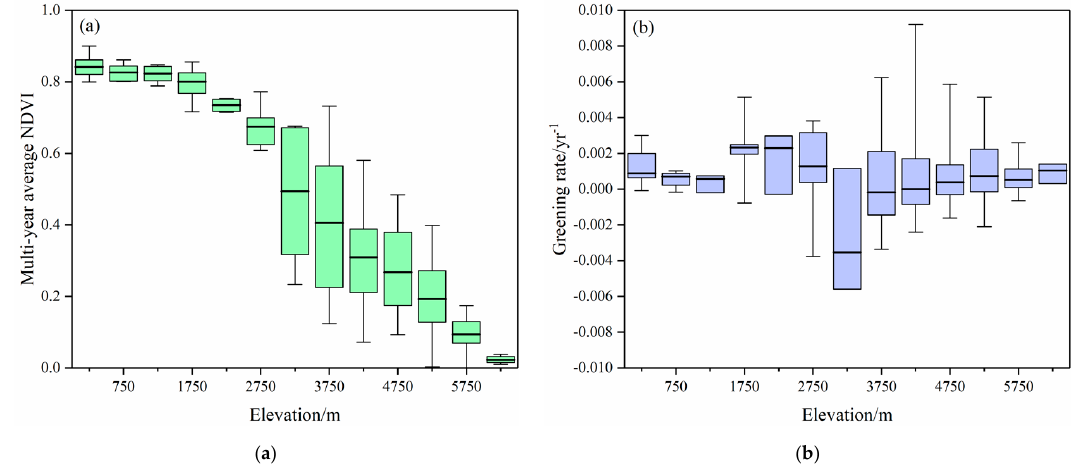
Figure 5. Multi-year average growing season NDVI ( a ) and greening rate ( b ) variations at different elevation belts.